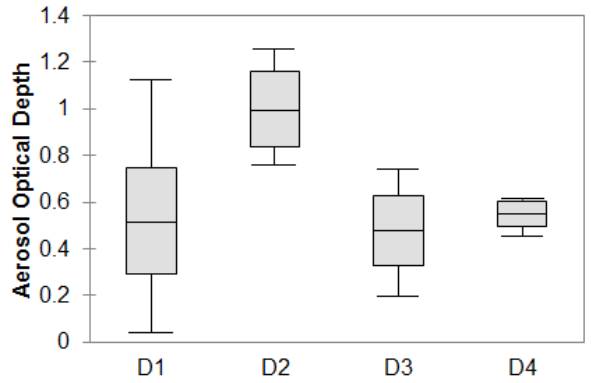
Figure 7. Statistical characteristics of aerosol optical depth varia- tion in MODIS Deep Blue (550nm) data set during four dust storm days (from the combined data set of Terra and Aqua). The top bar shows the maximum AOD of the day recorded by satellite; the bot- tom bar shows the minimum AOD of the day recorded by satellite; the bar in the rectangle shows the mean AOD value of all satellite records during the day; top and bottom edges of the rectangle show the values one standard deviation away from the mean AOD.